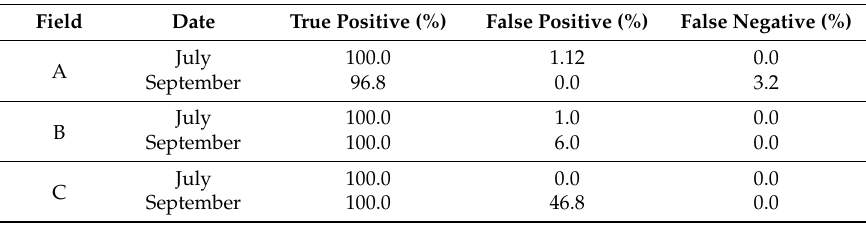
Table 6. Results of the gap detection in vine rows. Percentages were calculated over the total length of gaps in the field.